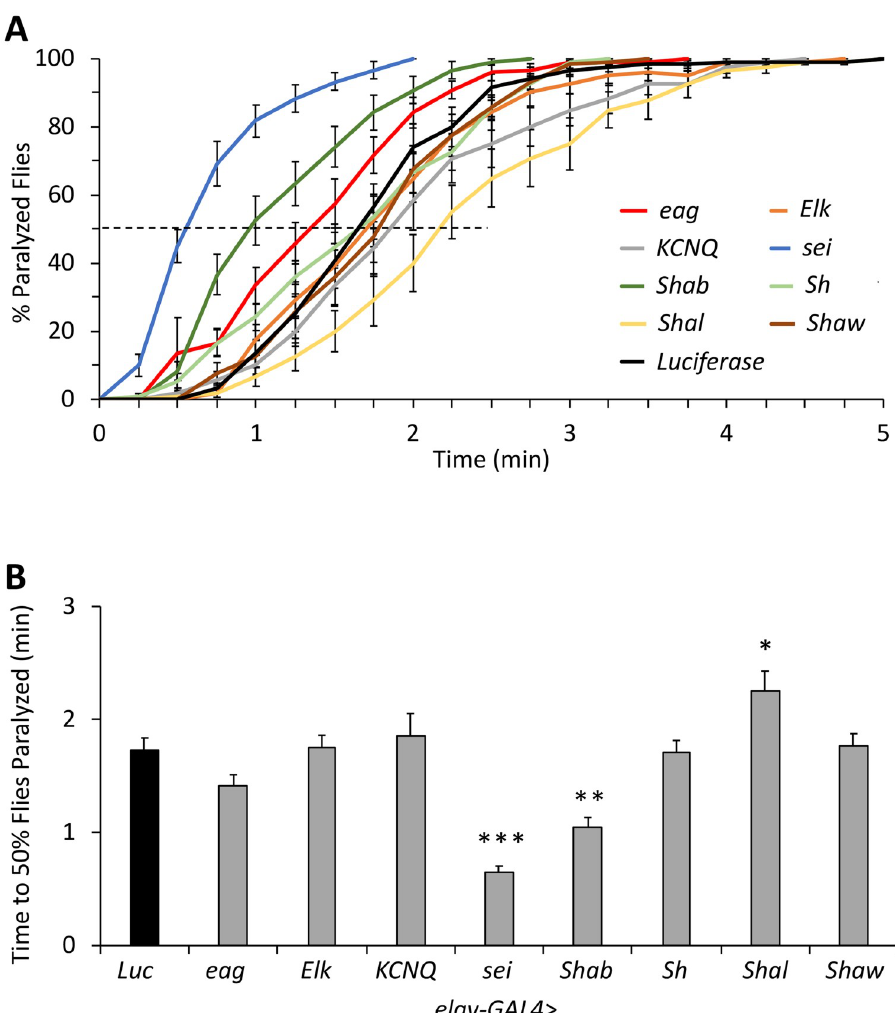
Fig 1. Neuronal ( elav-GAL4 ) RNAi knockdown screen of Drosophila genes encoding voltage gated potassium channels. A ) Cumulative percent paralyzed flies over time, with dotted line indicating 50% level. B ) Direct comparison of time at which 50% of flies are paralyzed, using the same data as in A. n = 12 vials/genotype, 10 flies per vial, placed in 41–42˚C water. ANOVA ( p < 0.0001) followed by Dunnett’s post hoc test was used to determine groups significantly different than the Luciferase control. Data are presented as mean ± SEM, � p < 0.05, �� p < 0.01, ��� p <